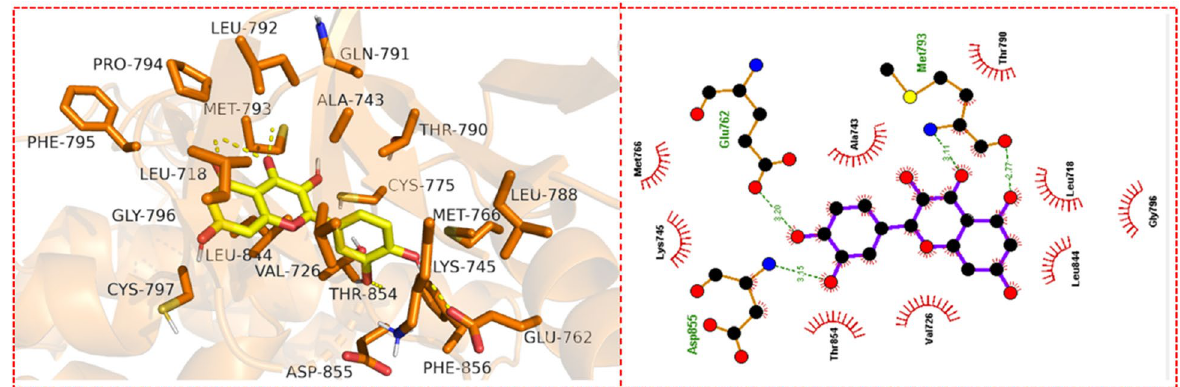
Fig. 9 2D and 3D interactions of EGFR-quercetin complex. The left part of the figure depicts the 3D interaction while the right part depicts the 2D